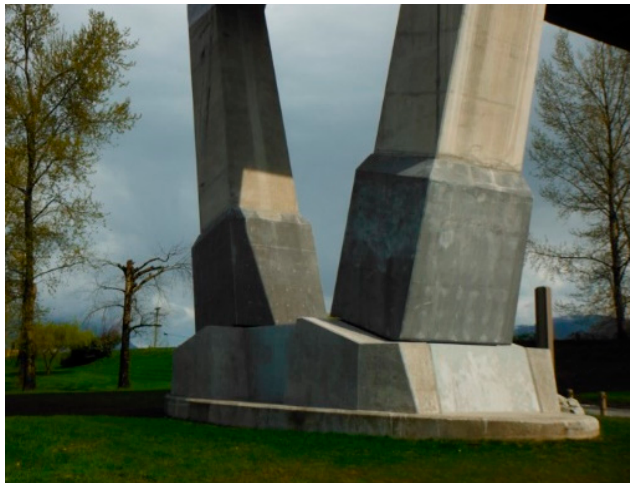
Figure 4. Representative apps of UHPC in BEs: pier jacket [99] .